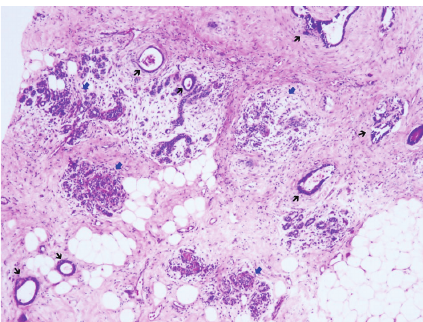
Figure 4: Tissue core biopsy from suspicious areas shows benign appearing breast terminal ductal-lobular units (TDLU) (blue arrows), interspersed by neoplastic colonic glands (black arrows) without any in situ carcinoma component (Hematoxylin and Eosin stain, 40x magnification).